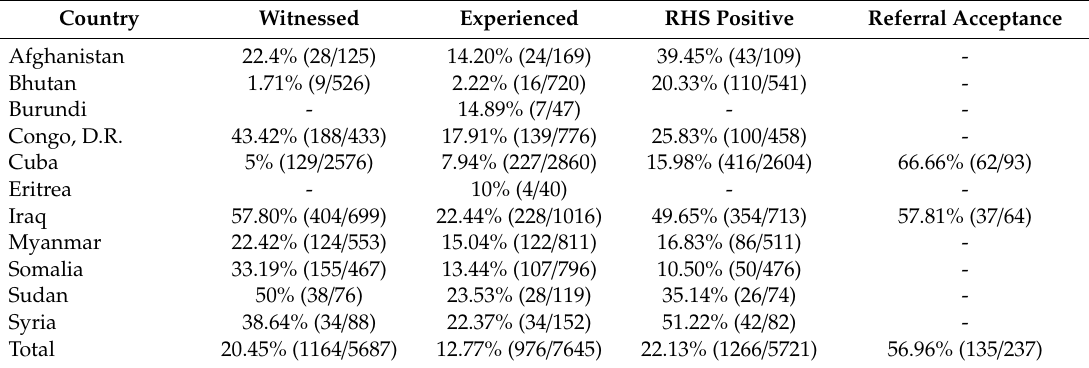
Table 1. Distribution of respondents who witnessed / experienced torture, violence, and imprisonment, recorded Refugee Health Screener-15 (RHS-15) positive, and referral acceptance rate by country of origin.